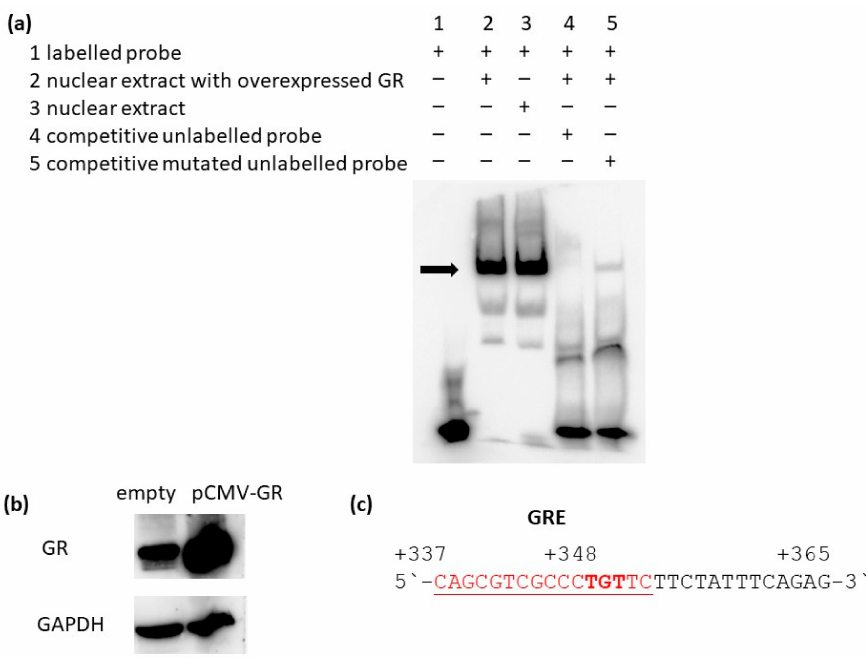
Figure 4. GR directly binds to the putative GRE site at +352 of the human RANKL proximal promoter. ( a ) Electrophoretic mobility shift assays using 293T nuclear extracts and biotinylated oligonucleotide probes containing site +352 downstream of the RANKL transcription start. Lane 1, negative control without nuclear extract; lane 2, nuclear extract with overexpressed GR protein added; lane 3, nuclear extract from untransfected cells, lane 4, competitive unlabelled probes added; lane 5, mutated competitive unlabelled probe added. ( b ) Western blotting using anti-GR antibodies of cell lysates with transfected (GR) and untransfected nuclear extracts (empty) used for the electrophoretic mobility shift assays in ( a ). anti-GAPDH was used as a loading control. ( c ) Nucleotide sequence of the biotinylated probe, GRE site is